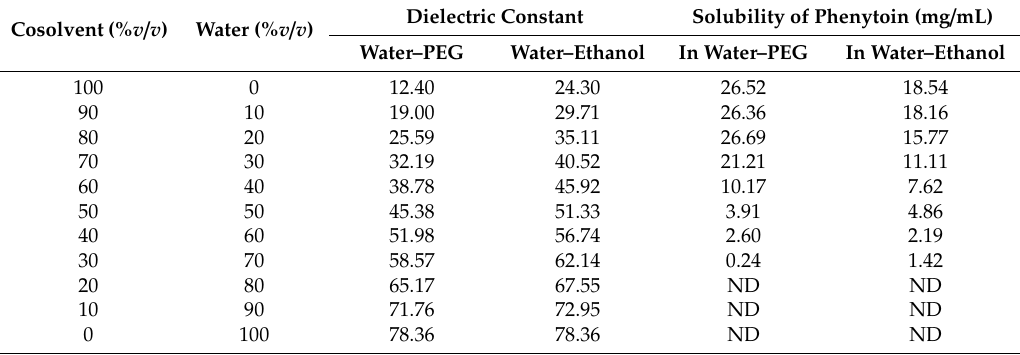
Table 2. Solubility profiles of phenytoin in water–polyethylene glycol (PEG) and water–ethanol mixtures of di ff ering dielectric